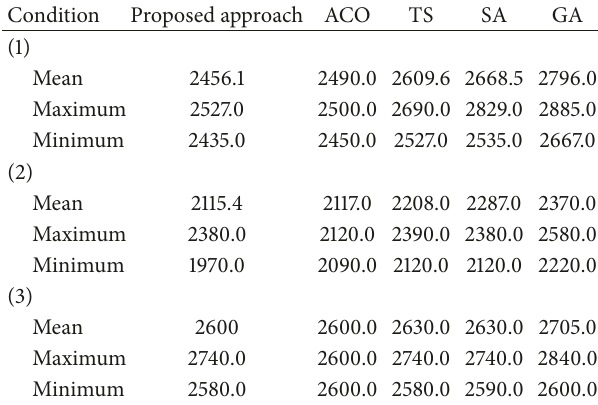
Table 12: Results compared to other algorithms for Part